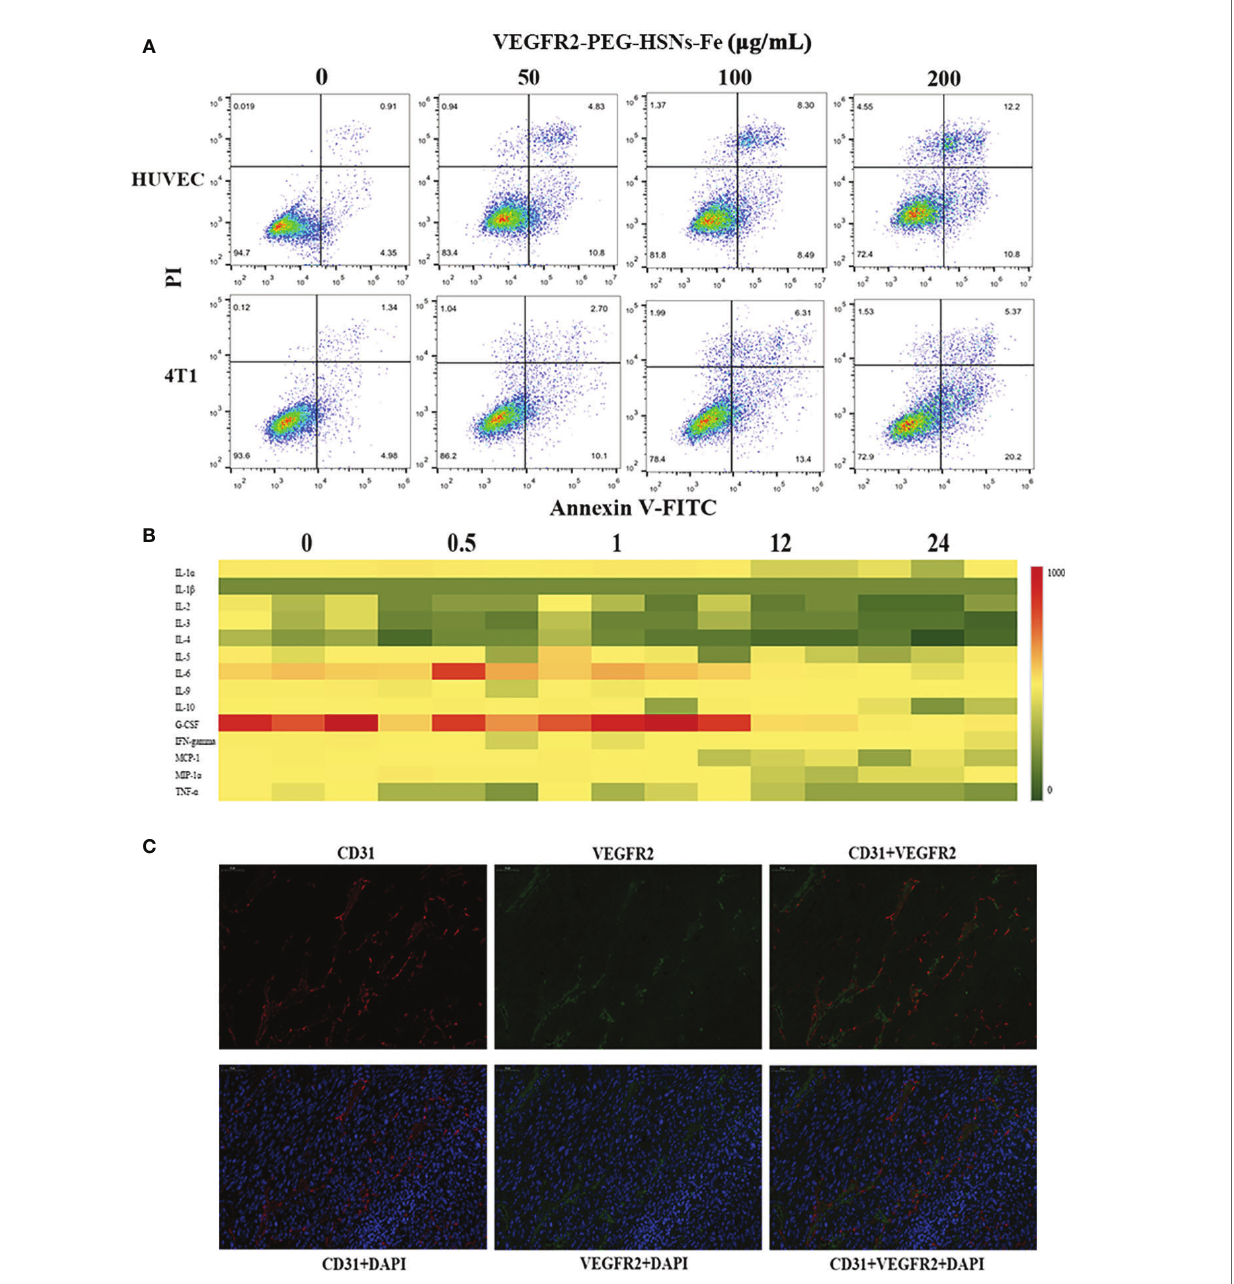
FIGURE 4 | (A) FCM images of HUVEC and 4T1 cells at different concentrations of VEGFR2-PEG-HSNs-Fe (50, 100, 200 m g/ml) and PBS for 24 h. (B) Heat map of main serum immune factors in nude mice with breast tumor injected with VEGFR2-PEG-HSNs-Fe at different time (0, 0.5, 1, 12, 24). (C) Immuno fl uorescence staining images of 4T1 tumor tissue slices (magni fi cation: ×400). CD31 was labeled by red fl uorescence, VEGFR2 by green fl uorescence, and tumor nucleus by blue fl